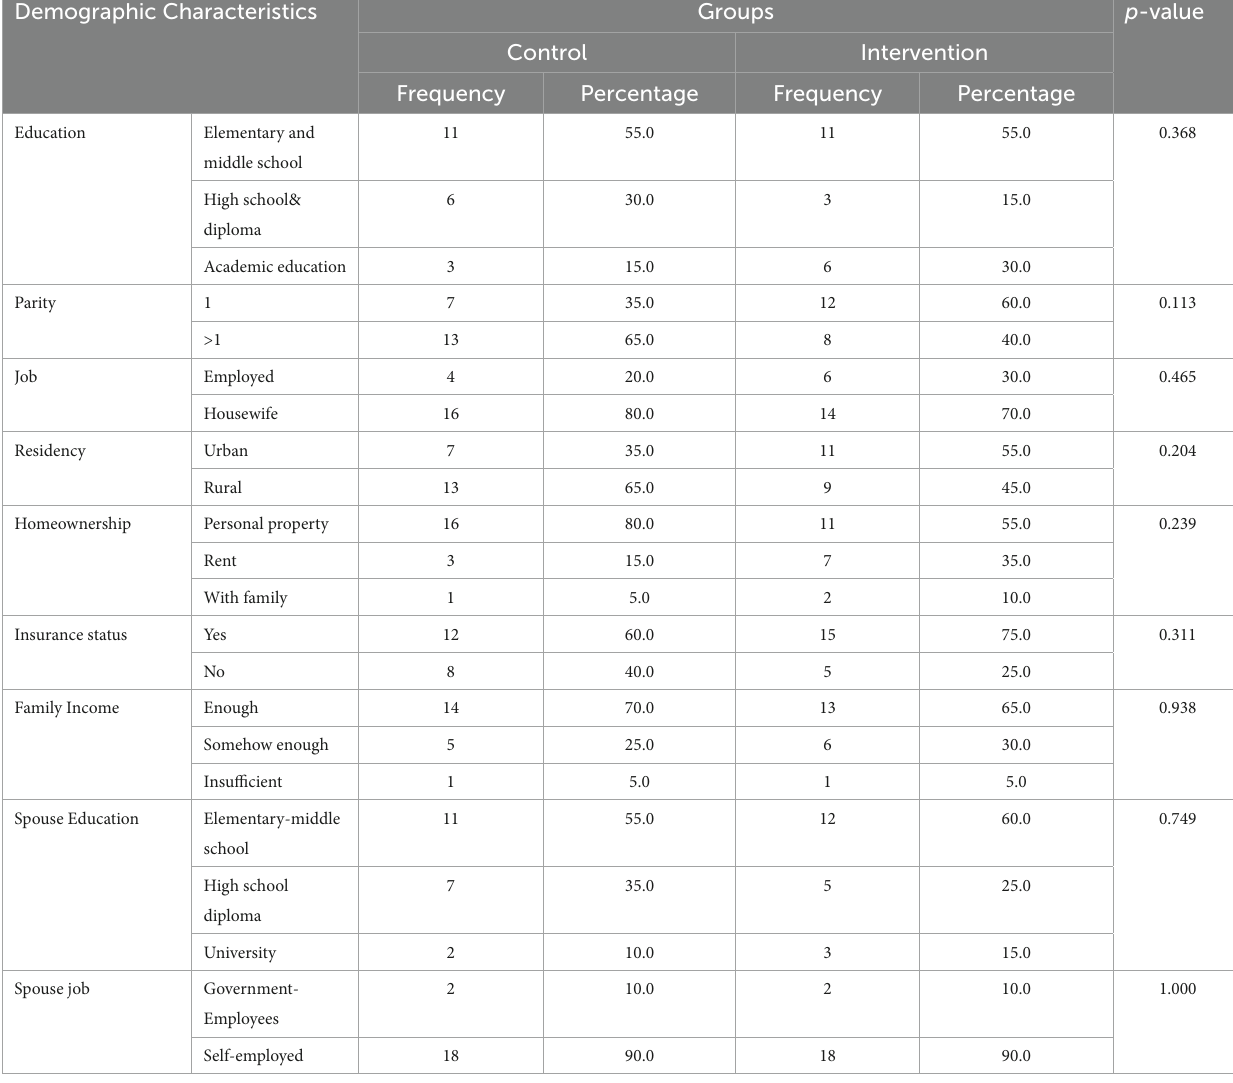
TABLE 2 The comparison of participants’ demographic characteristics between two groups. Demographic